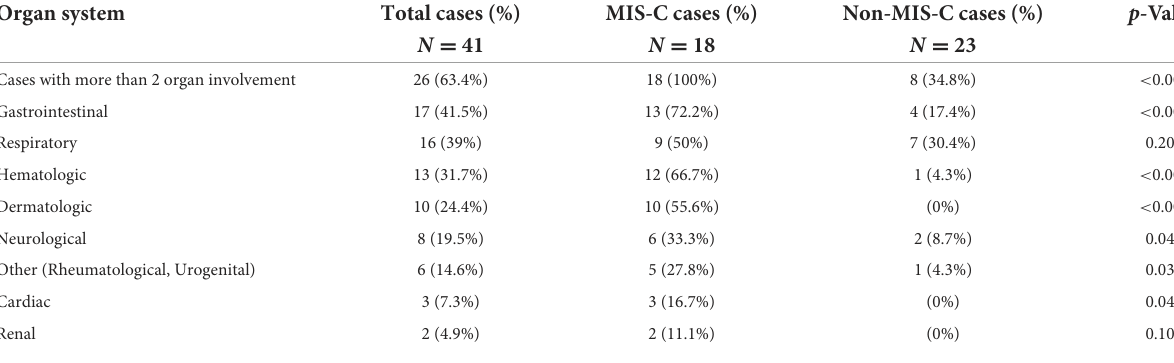
TABLE 3 Organ system involvement in hospitalized children and adolescents with MIS-C *